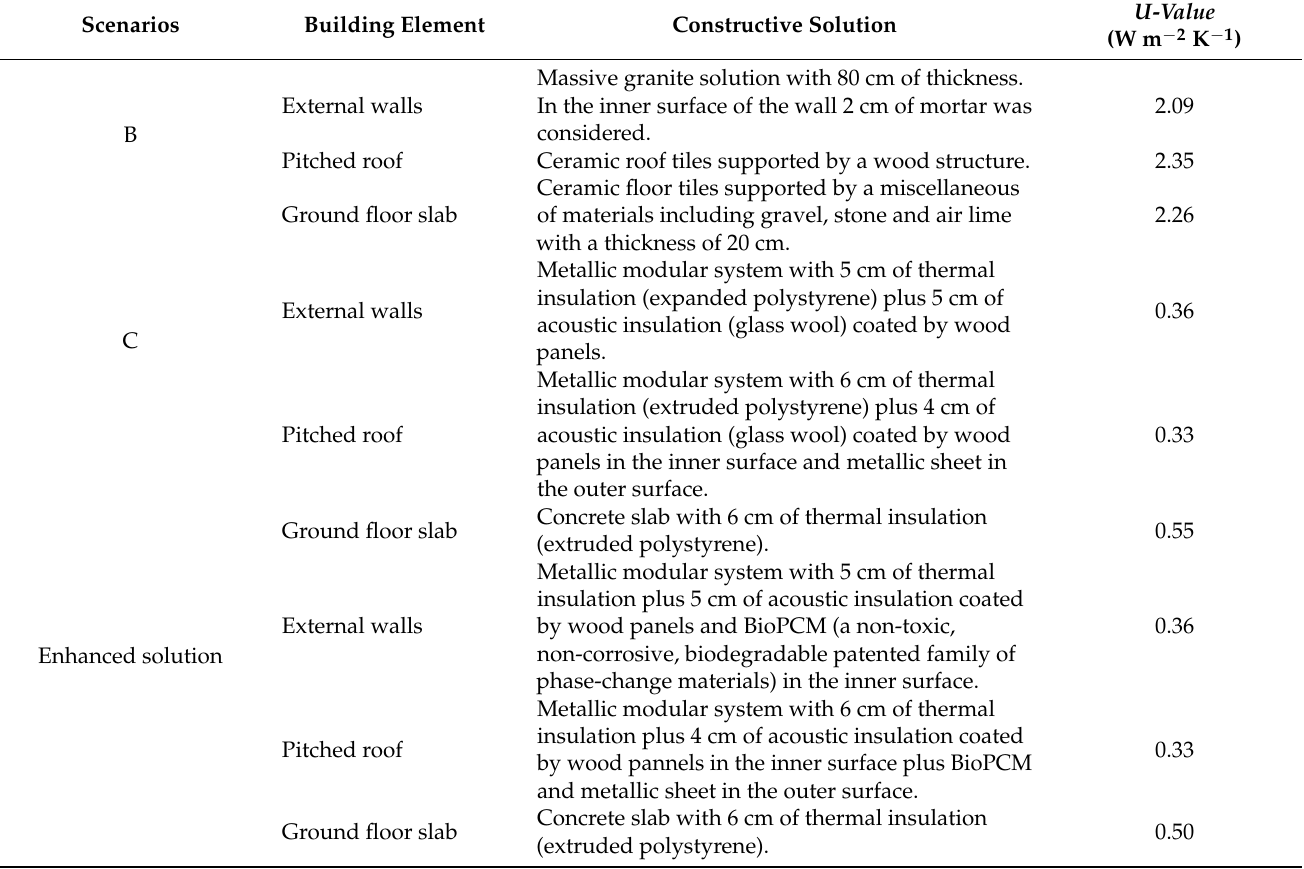
Table 4. Scenarios constructive solutions.